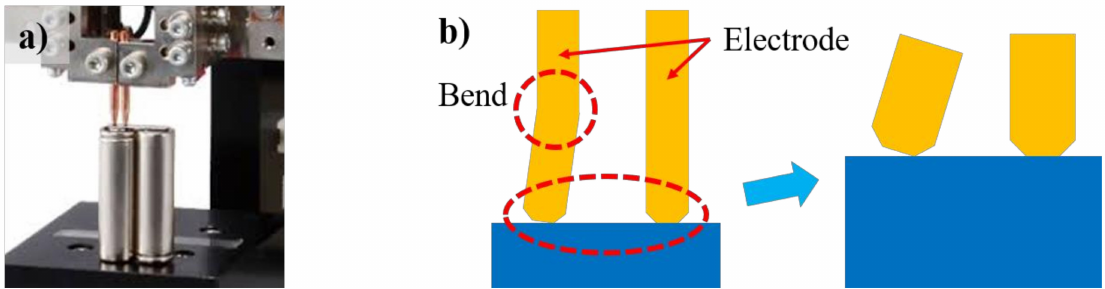
Figure 2. ( a ) Resistance spot welding, ( b ) Electrode bending due to high temperature.